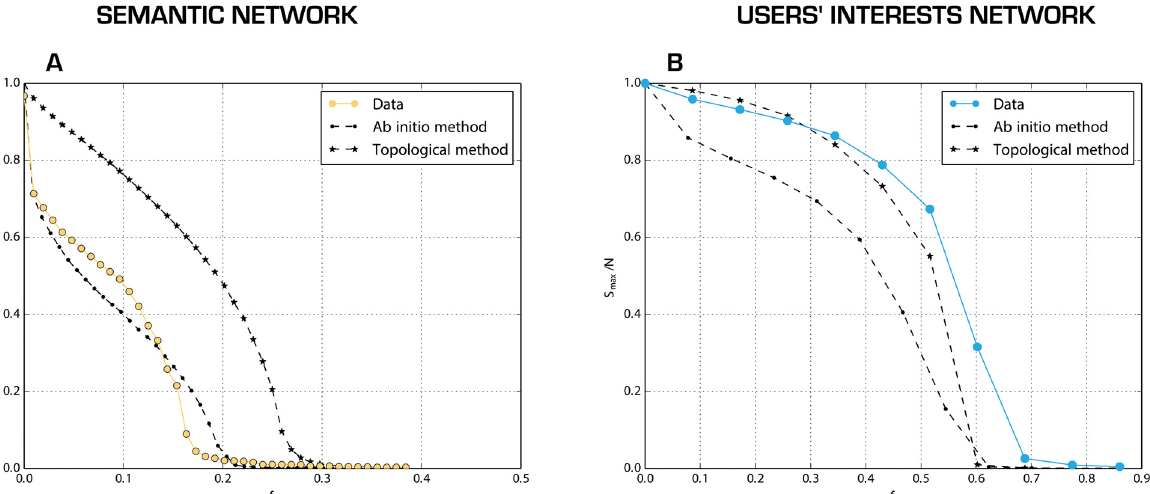
Fig 4. Robustness of the two mono projections of the network as a function of the removal of nodes (target strategy). On the y-axes the size of the largest connected part of the network normalized to the size of the network, on the x-axis the fraction of nodes removed. On the left semantic network, on the right users interest one. The colored lines correspond to the results relative to the original networks. The black lines correspond to cases when network has been re-shuffled using ab-initio (dashed line) and the topological method (star-lined). The results are averaged on 100 replicas of the attack model and, for the rewired networks, for 50 replicas of the reshuffling